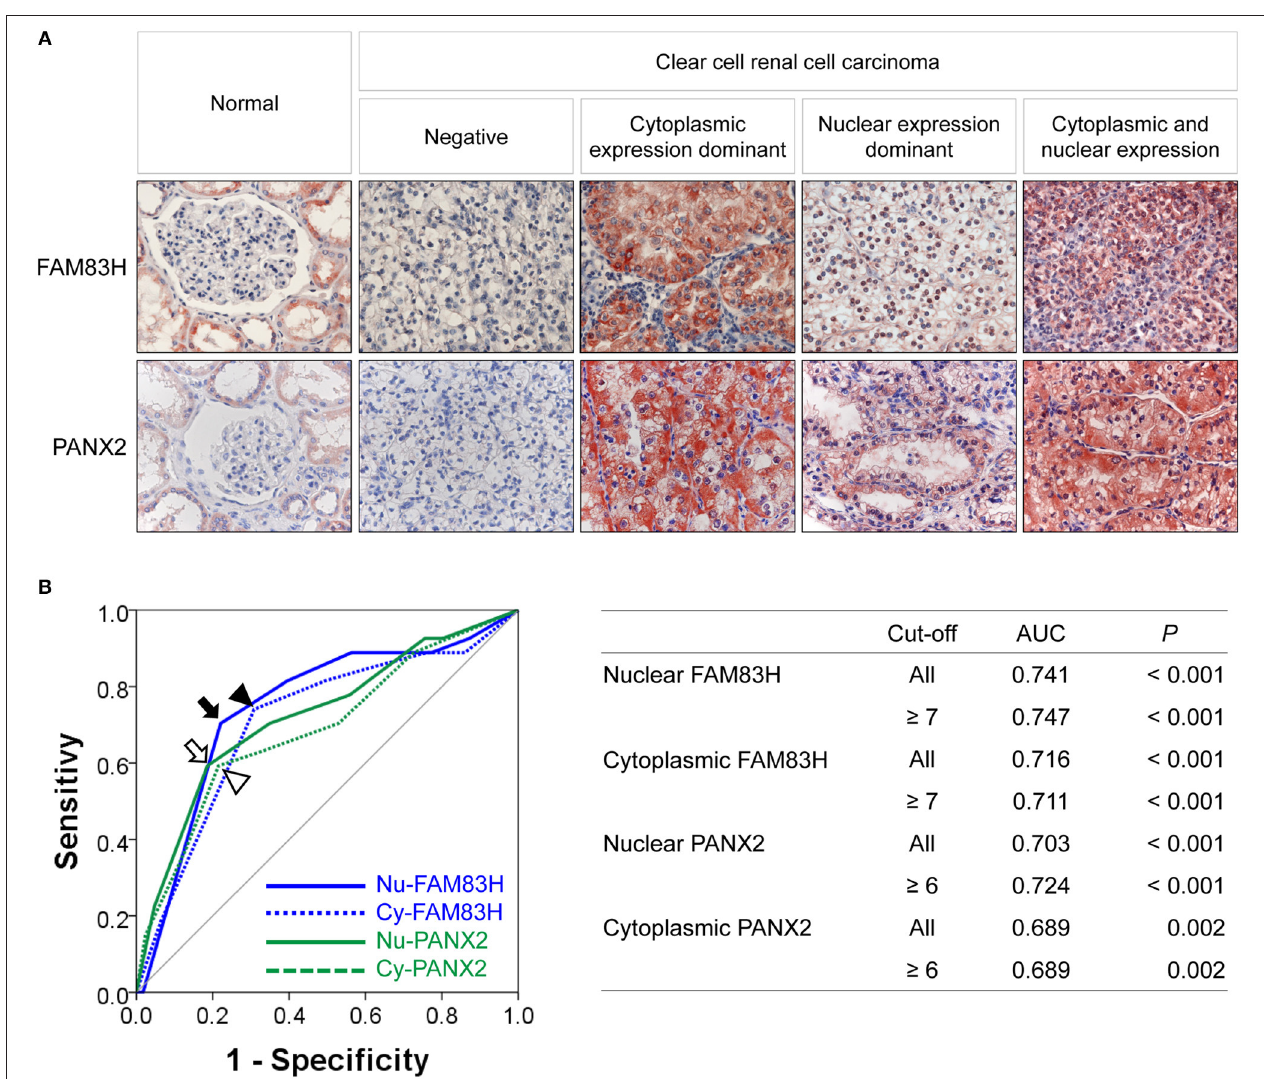
FIGURE 1 | Immunohistochemical expression of FAM83H and PANX2 in clear cell renal cell carcinomas and statistical analysis. (A) Immunohistochemical expression of FAM83H and PANX2 in normal renal parenchyma and clear cell renal cell carcinoma cells. In normal tissue, FAM83H and PANX2 are expressed in the cytoplasm of renal tubular epithelium. In clear cell renal cell carcinoma cells, FAM83H and PANX are expressed both in the cytoplasm and the nuclei. Original magnification; x400. (B) The cut-off values for nuclear FAM83H (Nu-FAM83H), cytoplasmic FAM83H (Cy-FAM83H), nuclear PANX2 (Nu-PANX2), and cytoplasmic PANX2 (Cy-PANX2) expression for classifying as negative- and positive-subgroups were determined by receiver operating characteristic curve analysis. The cut-off points were determined at the point with the highest area under the curve (AUC) to estimate death of clear cell renal cell carcinoma patients. The arrow (Nu-FAM83H), arrowhead (Cy-FAM83H), empty arrow (Nu-PANX2), and empty arrowhead (Cy-PANX2) indicate the cut-off points on the receiver operating characteristic curve. The cut-off point for Nu-FAM83H and Cy-FAM83H was seven, and the cut-off point for Nu-PANX2 and Cy-PANX2 was